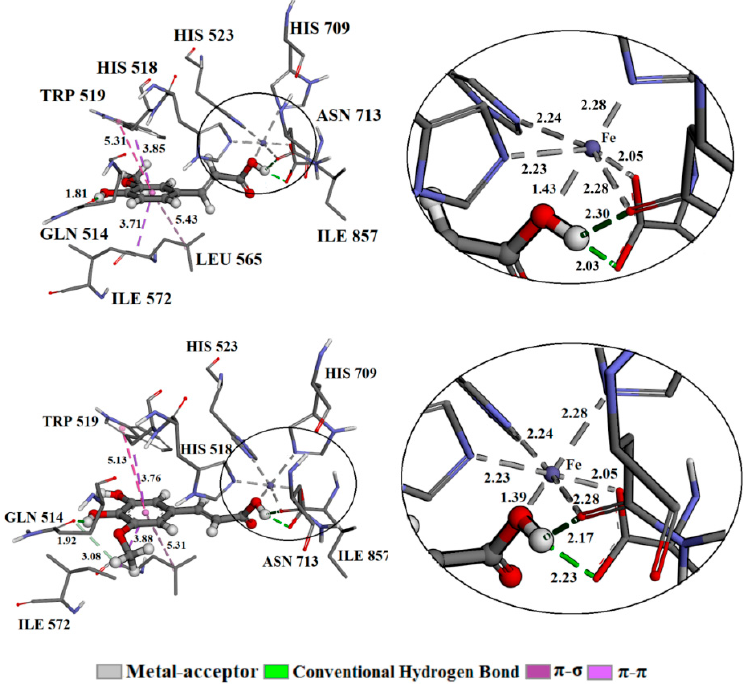
Figure 5. The best docking positions of FA (LOX-FA) and 5OHFA (LOX-5OHFA) compounds on the LOX enzyme. LOX